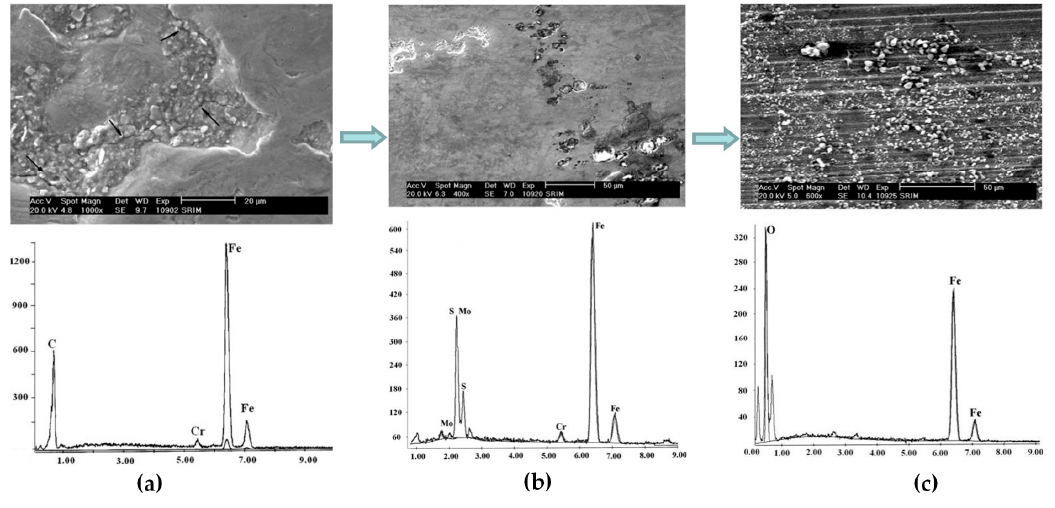
Figure 6. SEM and EDS of inner ring wear of bearings (Reprinted with permission from Ref. [76]. (Copyright 2011 Springer).